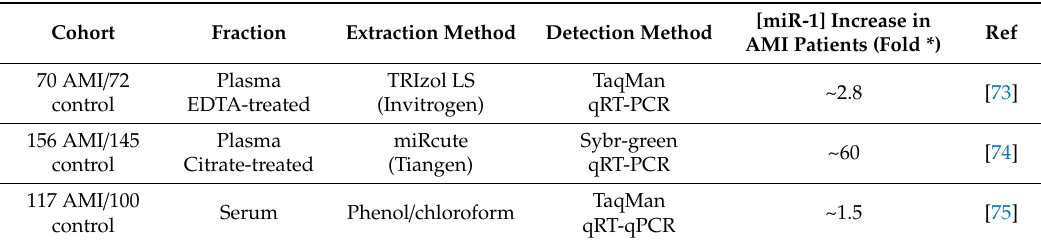
Table 2. A comparison of miR-1 expression levels between AMI patients and healthy individuals from di ff erent research